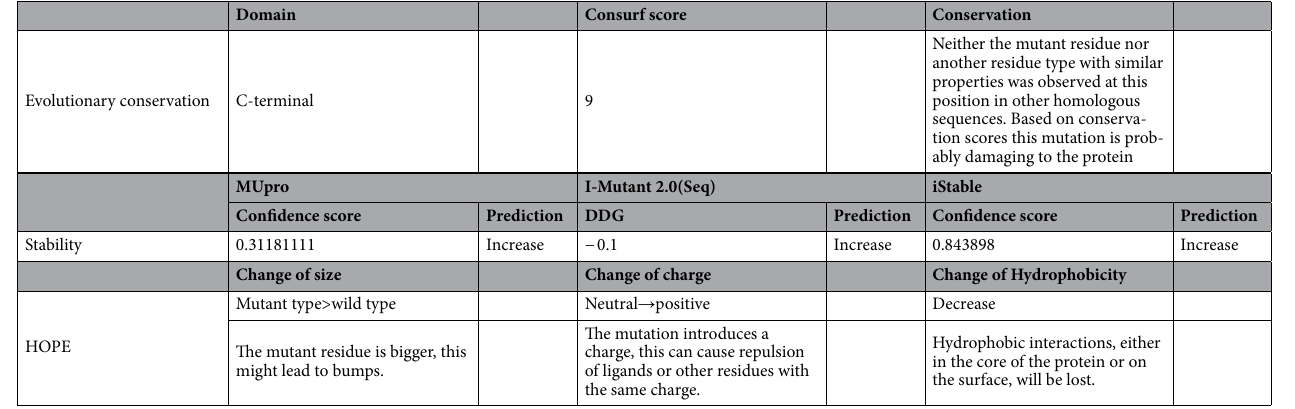
Table 4. Prediction of p.Ser807Arg mutatant protein by using Mupro, I-Mutant 2.0(Seq), iStable and